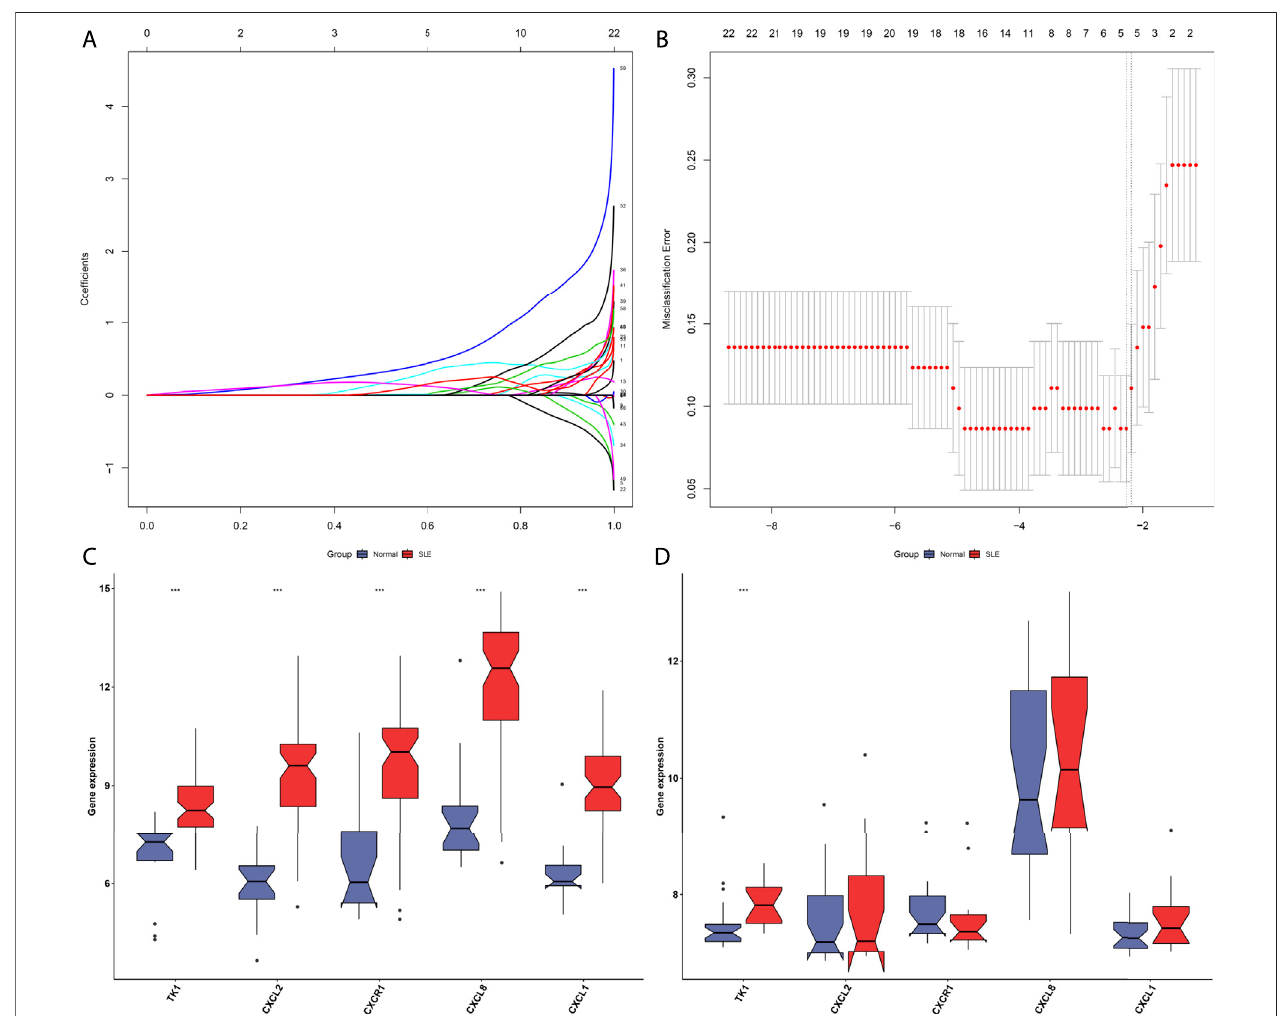
FIGURE 4 | Establishment of a LASSO model for distinguishing SLE from normal controls. (A) Ten-fold cross-veri fi cation of turning parameter selection in the LASSO model. (B) LASSO coef fi cient pro fi ling ofthe hub genes. (C) Boxplots show theexpression of characteristic genesin SLE and normal PBMCsin the GSE50772 dataset. (D) Veri fi cation of the expression of characteristic genes in SLE and normal PBMCs in the GSE81622 dataset. *** p <